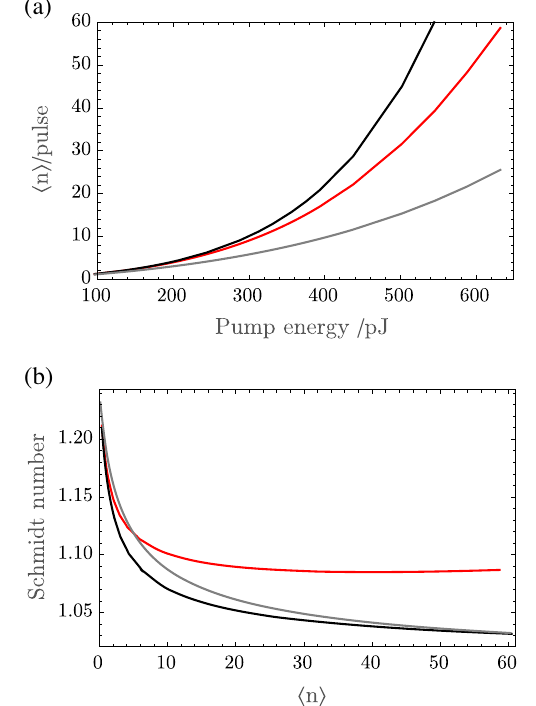
FIG. 8. (a) Number of spontaneously generated photons as a function of pump pulse energy. (b) Spectral Schmidt number as a function of the number of spontaneously generated photons. The redlineshowsthe χ ð 2 Þ = χ ð 3 Þ model;theblacklineisforthe χ ð 2 Þ model (onlyPDC,noSPMorXPM);andthegraylineisthesimplified χ ð 2 Þ p ffiffiffiffiffiffi c E model (squeezing parameters r ) with the same predic- l ¼ l p tions in the low-gain regime. Note that the curves converge in the low-gain regime but scale differently for higher